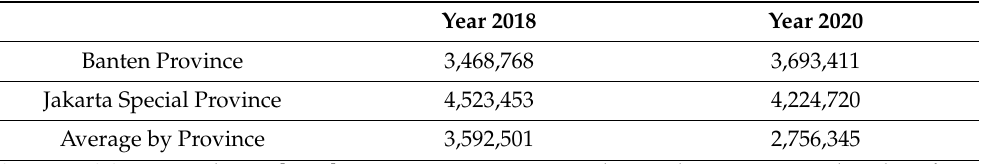
Table 2. Average of net wage/salary per month of formal employee by province and main occupation (Indonesia